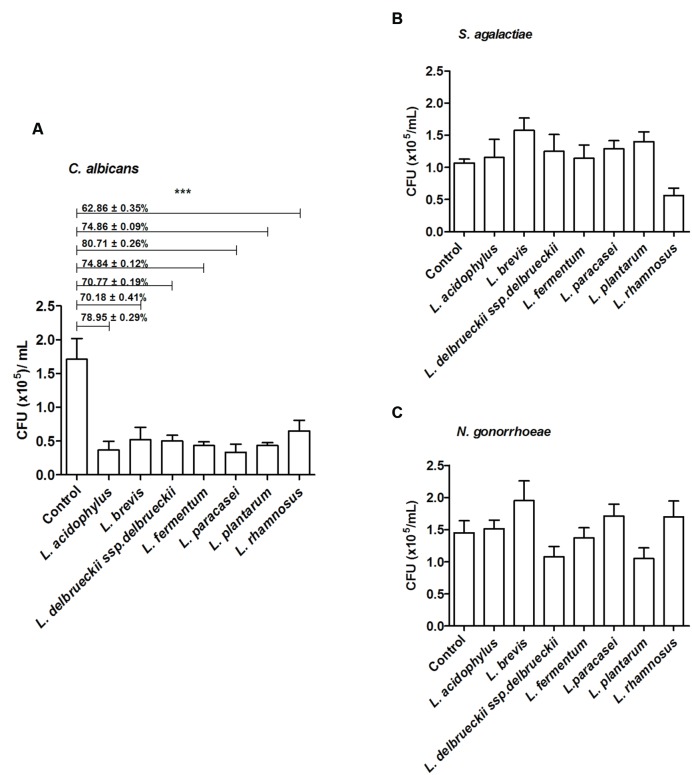
Inhibition of mucin adhesion by displacement. Effect of different lactobacilli on (A)
C. albicans, (B)
S. agalactiae, and (C)
N. gonorrhoeae binding to mucin. The values are expressed in CFU/ml and represent the means of the values obtained. For all experiments, the purity of the colonies was checked both macroscopically (by the growth aspects) and microscopically (by the Gram stain). The assay was performed in triplicate. ∗∗∗p < 0.001.